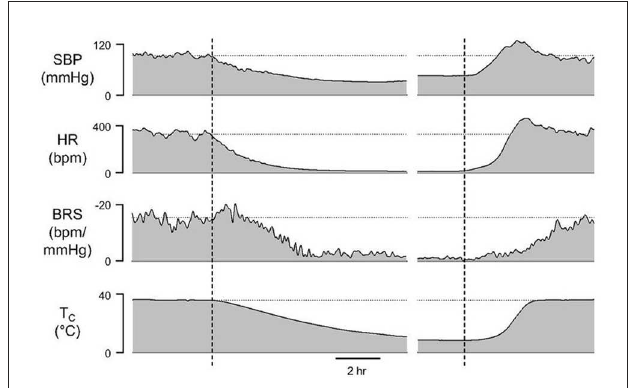
FIGURE4 A gradual increase in HR is the first sign of arousal although a rapid increase in systolic blood pressure (SBP) precedes the subsequent, rapid rise in HR. Maximal SBP during arousal overshoots SBP measured during euthermia. Minimal baroreceptor sensitivity (BRS) at the onset of arousal may allow for the rapid rise in SBP and HR that are needed to support the metabolic demands of heart and brain as animals rewarm from hibernation torpor seen as a change in core body temperature (T c ) [Horwitz et al. (33)].